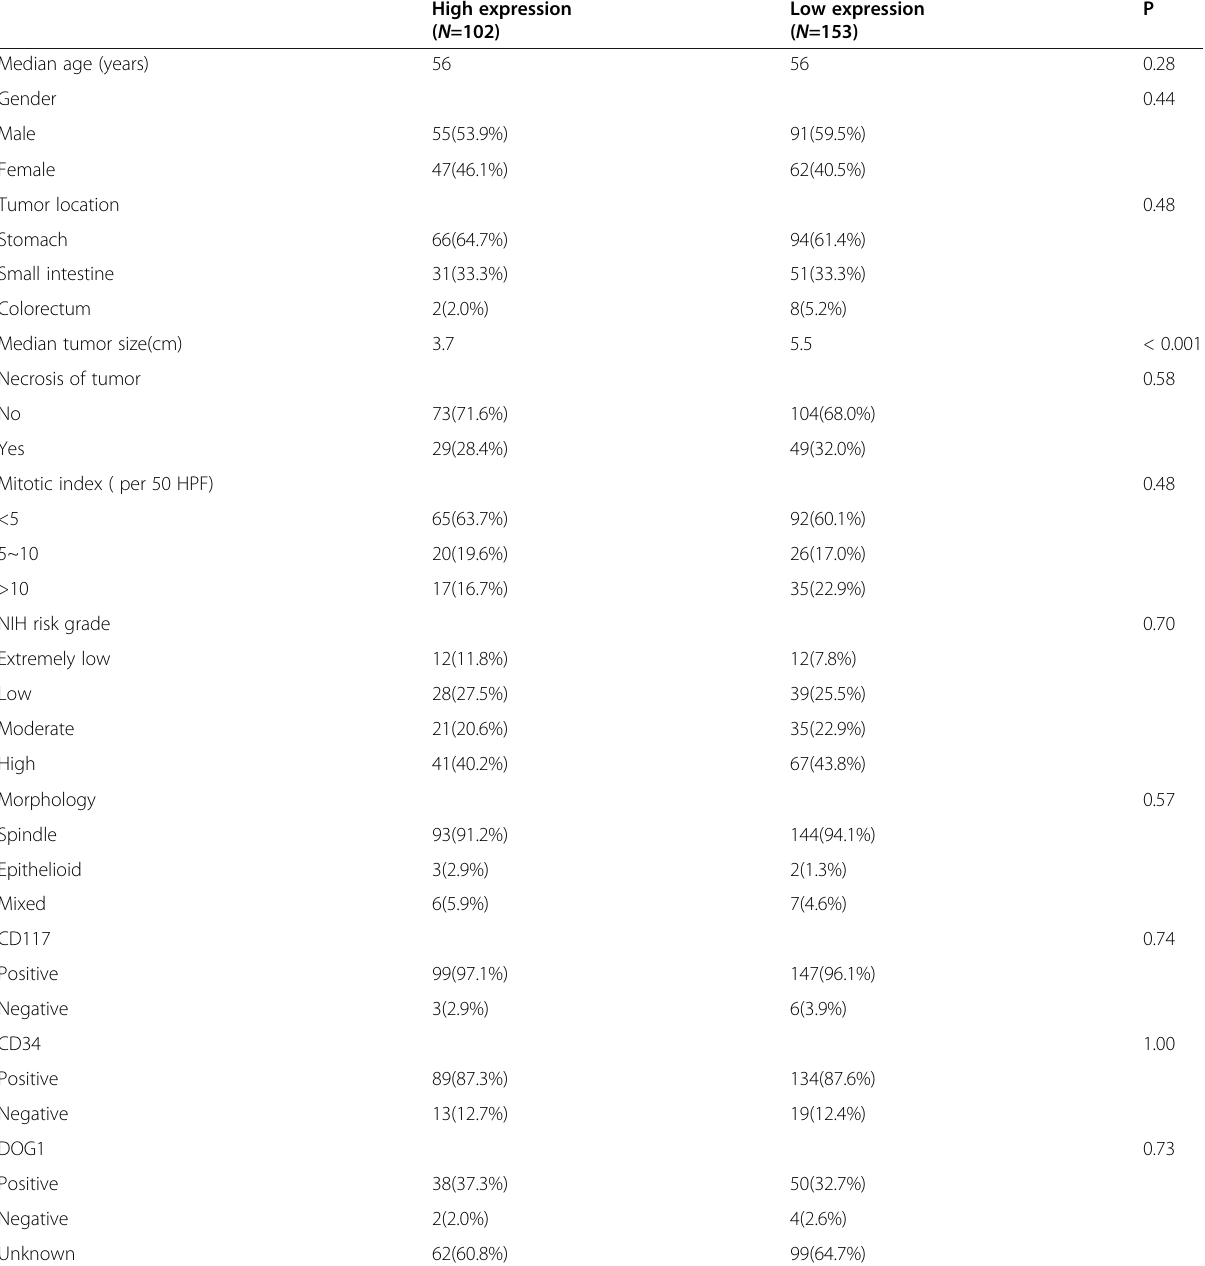
Table 1 Associations between SOCS6 expression and clinicopathological variables